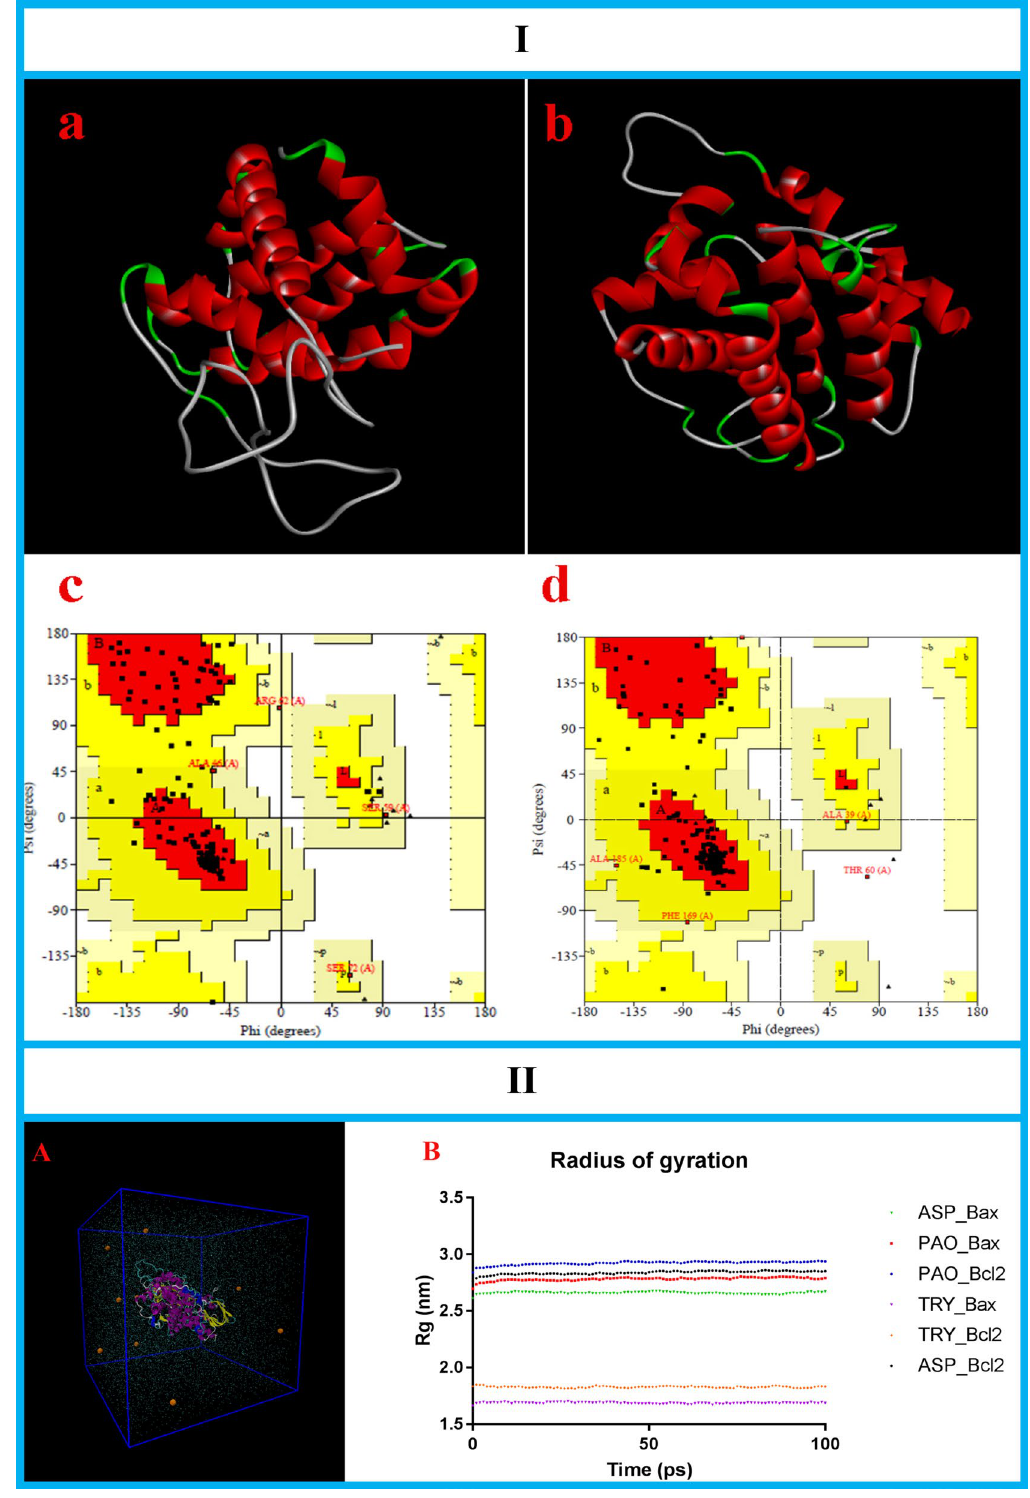
Figure 4. I ( Structural parameters of simulated proteins ( a and b ), Protein models of Bcl-2 and Bax ( Gallus gallus ), respectively The structures of Bcl-2 and Bax ( Gallus gallus ) were constructed using SWISS-MODEL (https ://swiss model .expas y.org/). ( c and d ) Ramachandran plots for protein model of Bcl-2 and Bax ( Gallus gallus ), respectively. Ramachandran plot was created using PROCHECK server,https ://servi cesn.mbi.ucla.edu/PROCH ECK/). II (Molecular dynamics simulations ( A ) Simulated proteins solvated in SPC water (cyan) and sodium ions (orange). ( B ) Radius of gyration values for simulated proteins. By calculating the radius of gyration, it is revealed that the proteins remain stable, over the course of runs. ASP aspartic proteinase, PAO polyamine oxidase, TRY tryptophol). Molecular dynamics simulation was performed using the GROMACS 5.4.1 package http://www.groma